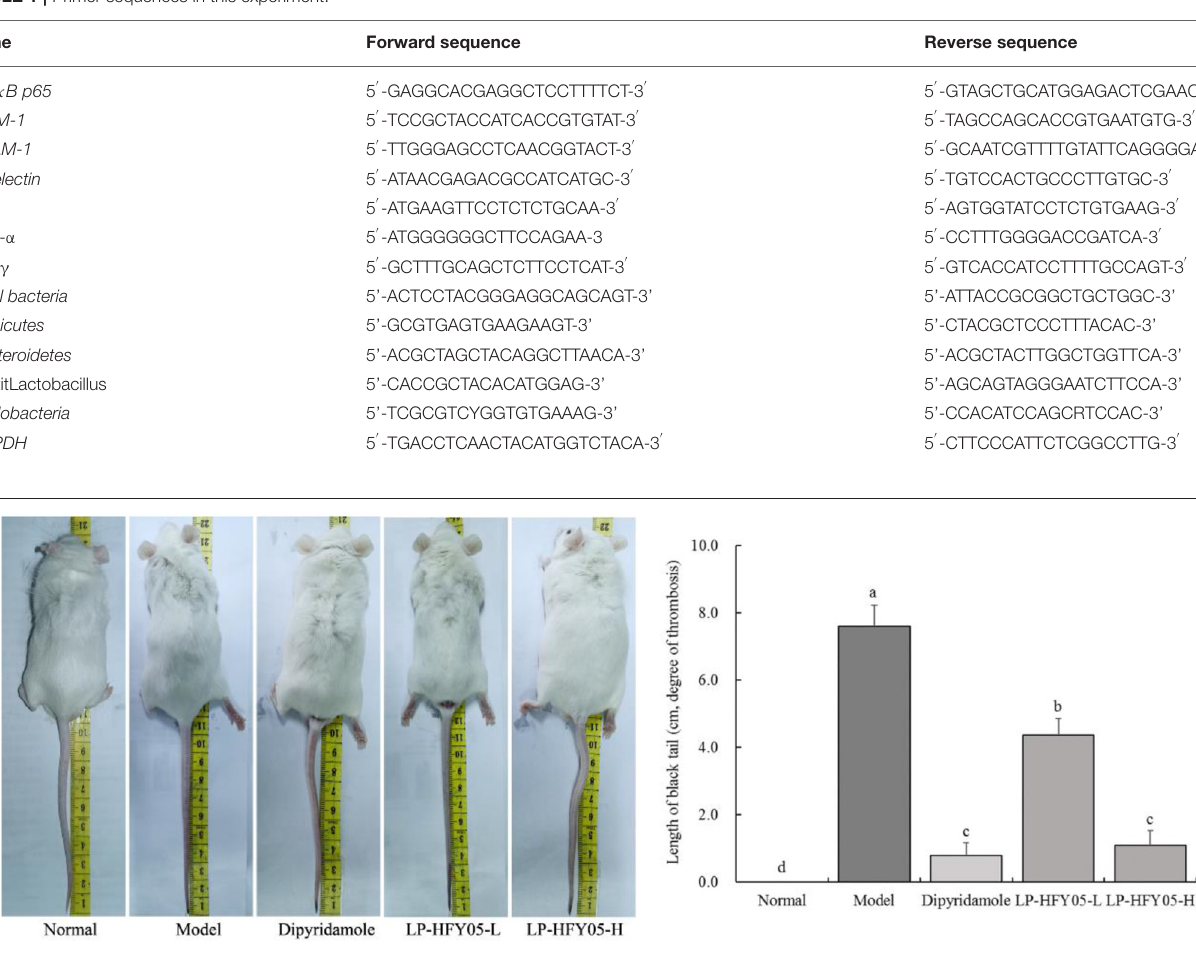
FIGURE 1 | Tail thrombus of mice in each group. a − d Mean values with different letters in the different bars were significantly different ( P < 0.05) according to the SNK multiple-range test; b, c, and d indicate significance vs the model group; the same letter of c indicates that there was no significant difference ( P > 0.05) between the two